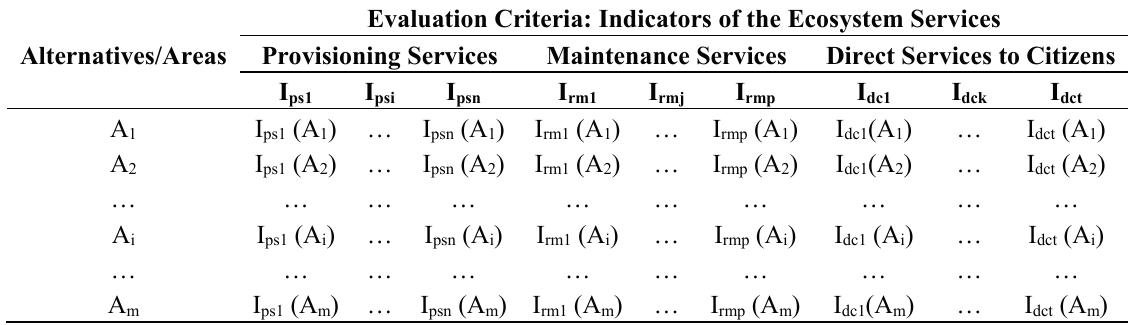
Table 1. Evaluation table of alternatives based on the ecosystem services.